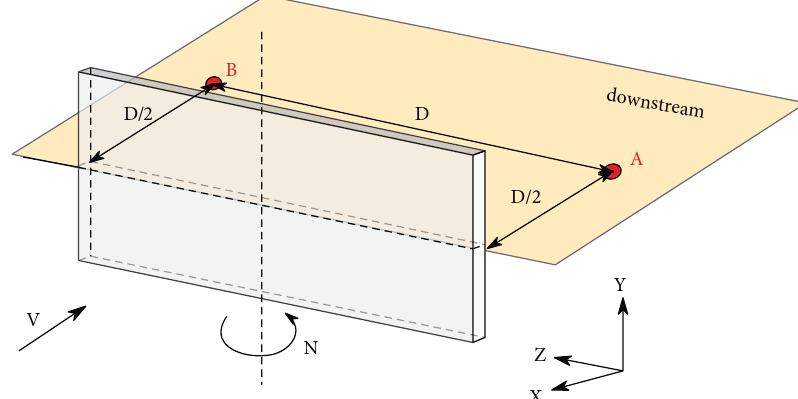
Figure 9: Schematic diagram of the location of the vorticity monitoring point downstream of the antenna (ZOX plane and Y �